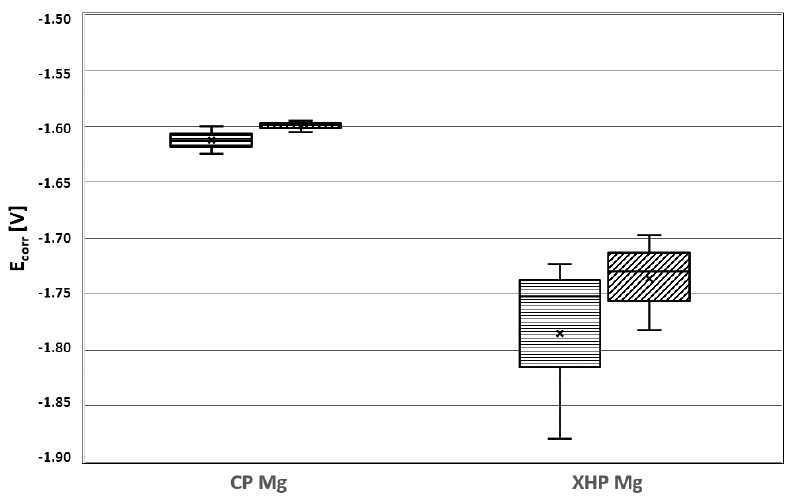
Figure 9. E corr for static and dynamic conditions for XHP Mg and cp Mg in